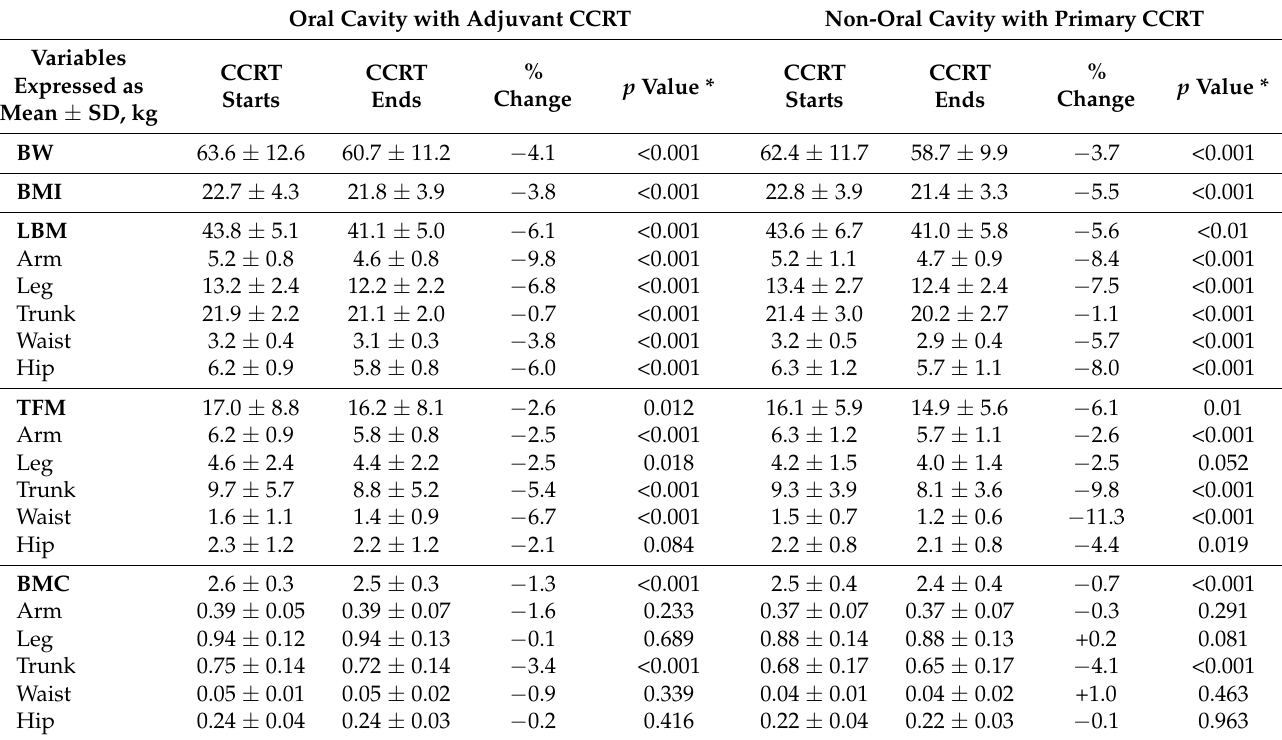
Figure 3. Percentage of treatment-interval changes in different body compartments of LBM, TFM, and BMC for both oral cavity cancer and non-oral cavity cancer. The percentage of change at each body compartment is determined by (posttreatment value − pretreatment value)/(pretreatment value) × 100%. * denotes p < 0.05, considered significant. LBM, lean body mass; TFM, total fat mass; BMC, bone mineral content; CCRT, concurrent chemoradiotherapy. Table 2. Treatment-interval changes in different body regions of DXA-derived body composition parameters in 127 LAHN- SCC patients stratified by tumor locations and CCRT